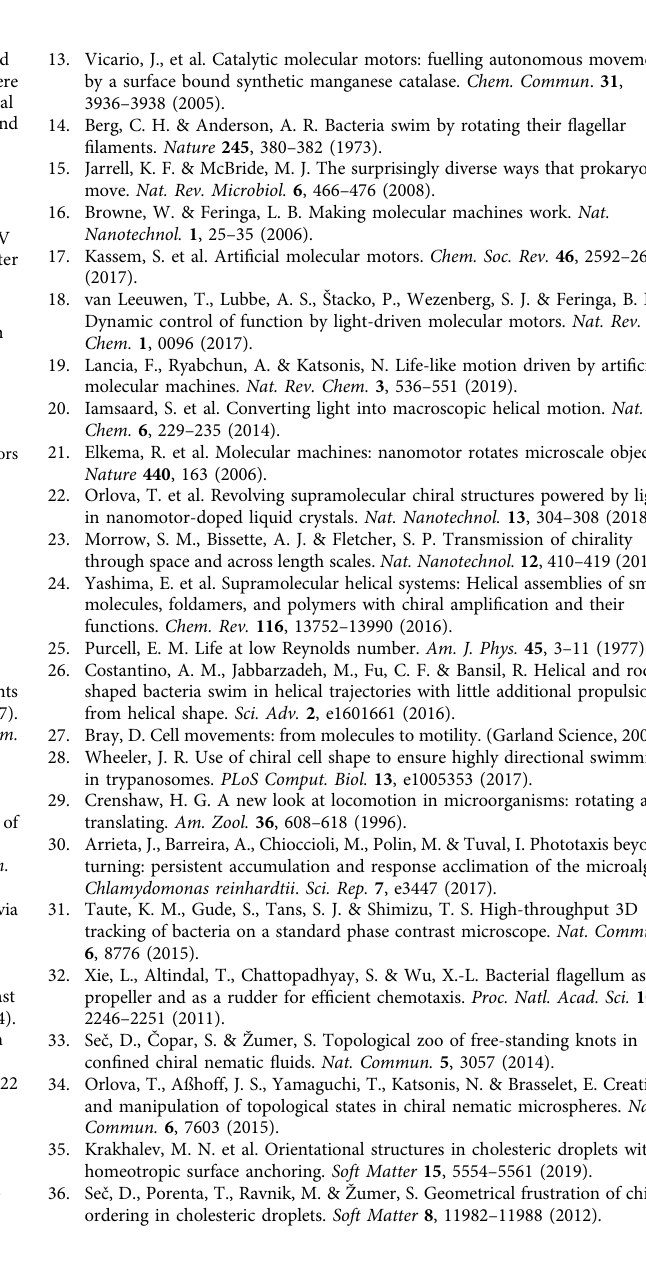
Fig. 5 In fl uence of kinetics of chirality inversion on the reorientation. The spiral droplet shown here is doped with Me- m . When the light power is suf fi ciently low, the helical trajectory unwinds slowly and then rewinds with helix inversion. The insets show the structure of the droplet during motion, with straight motion being associated with the disappearance of the spiral organization in the compensated state. The direction of the motion is not modi fi ed signi fi cantly upon transition from helical